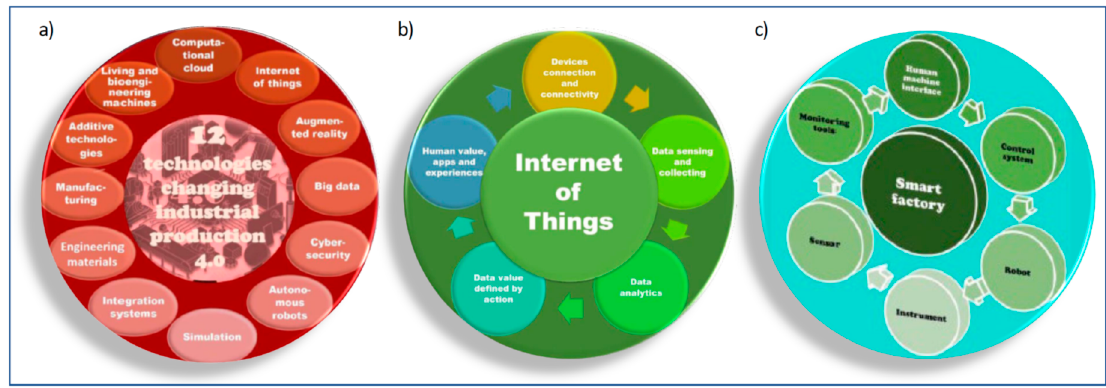
Figure 20. Diagram: ( a ) twelve technologies underlying the assumptions of Industry 4.0; ( b ) the Internet of Things; ( c ) interrelationships between smart elements of the Industry 4.0 system inside the Smart Factory.